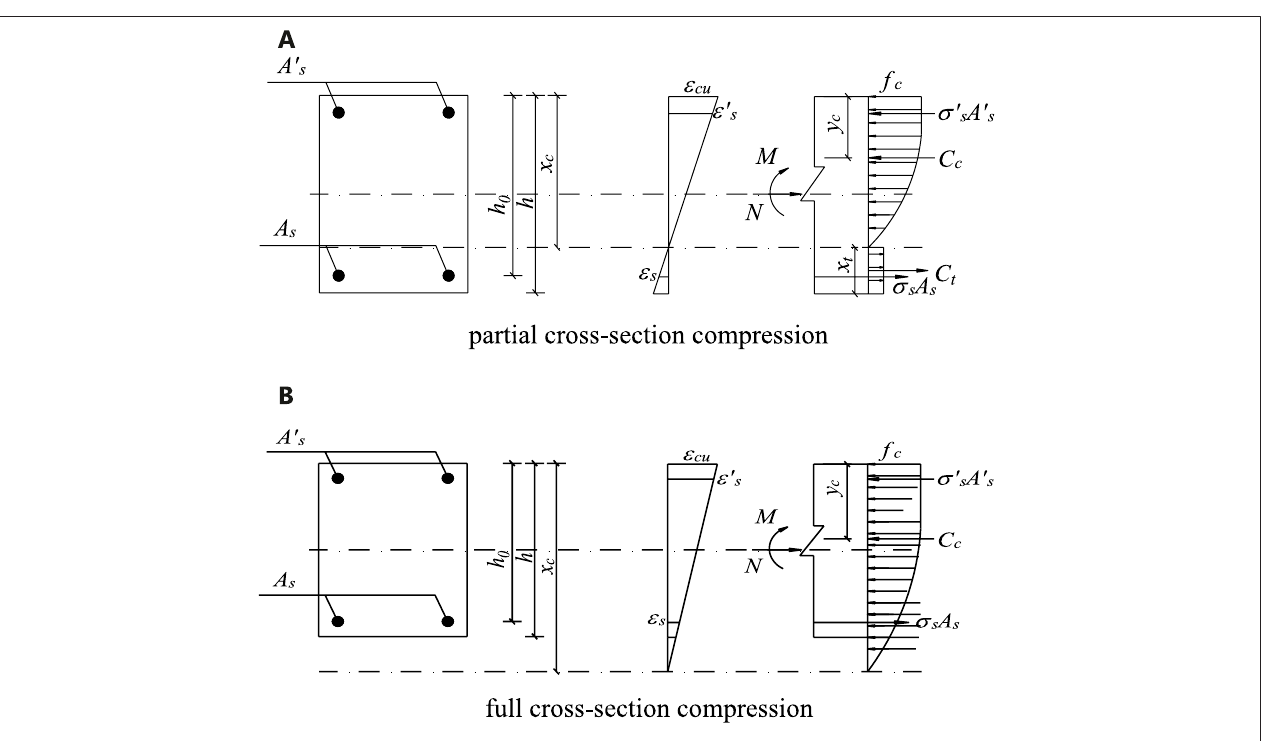
FIGURE 5 | Calculation diagram of RECC normal cross-section bearing capacity under small eccentric compression. (A) Partial cross-section compression. (B) Full cross-section compression.